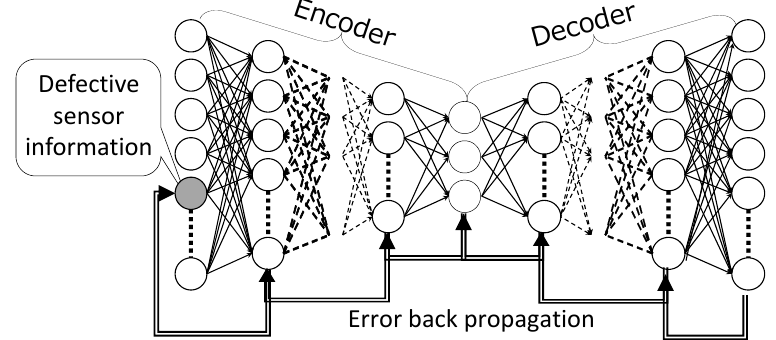
Figure 3. DSAE-BP: Repair the defects in sensor time-series by a BP method. Weights and biases of DSAE are not